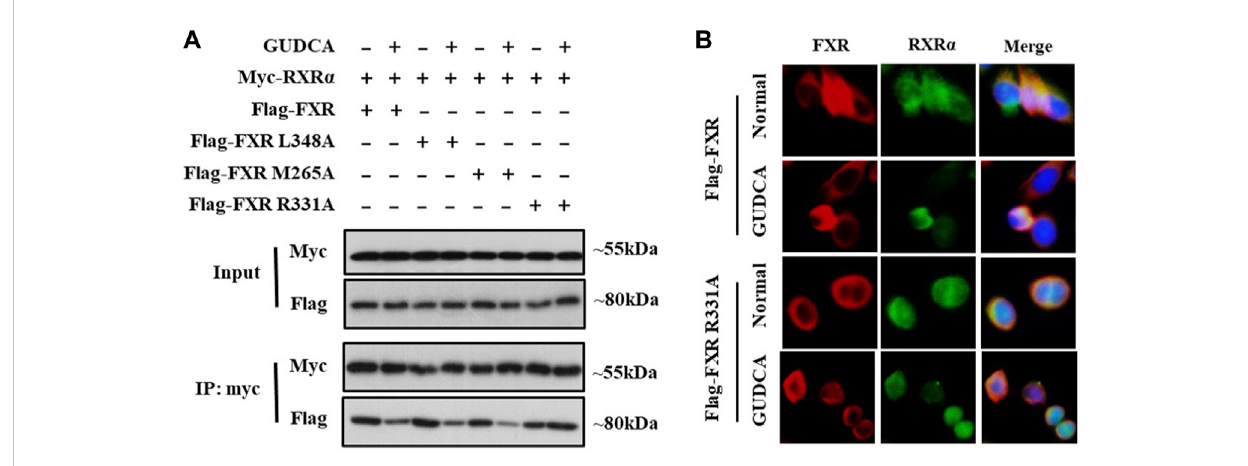
FIGURE 6 FXR is essential for GUDCA-alleviating mTOR pathway-associated proliferation in HepG2 cells. (A) MTT assay for detecting cellular proliferation, *** p < 0.001 compared to DMSO group; (B) Western blot for probing the expressions of p-mTOR, mTOR, and Flag; (C) Flow cytometry for detecting cell cycle